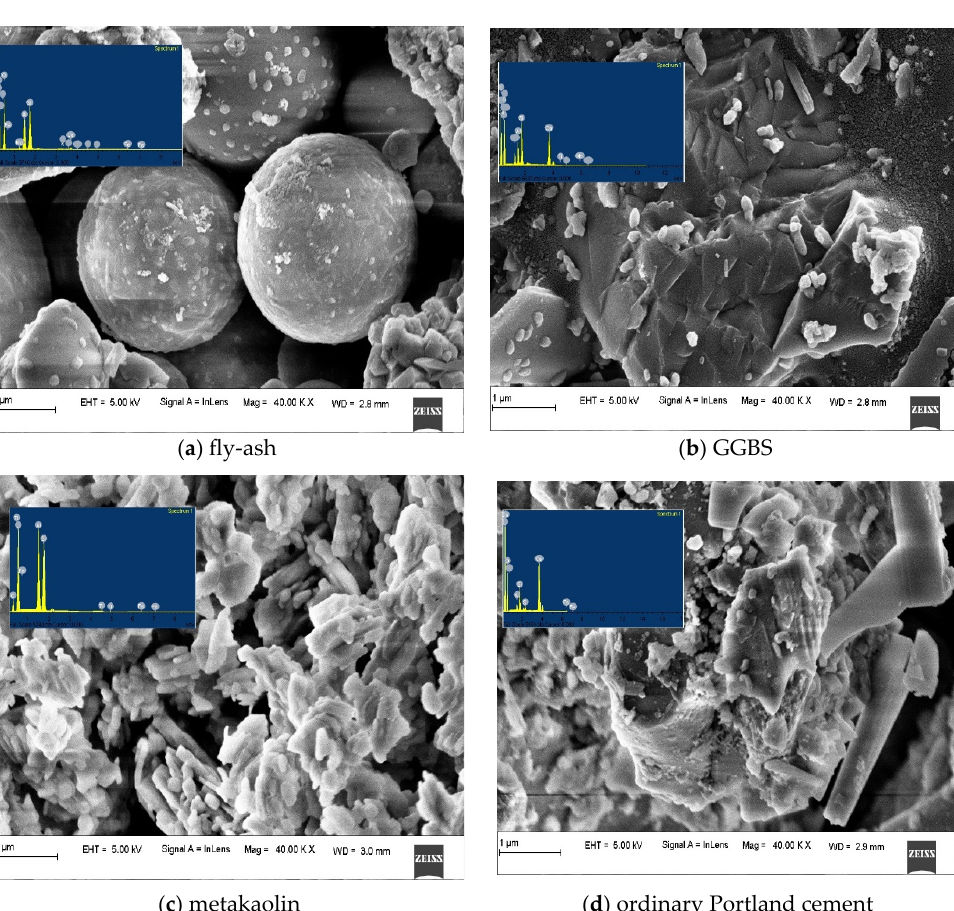
Figure 3. FE-SEM images of aluminosilicate materials.